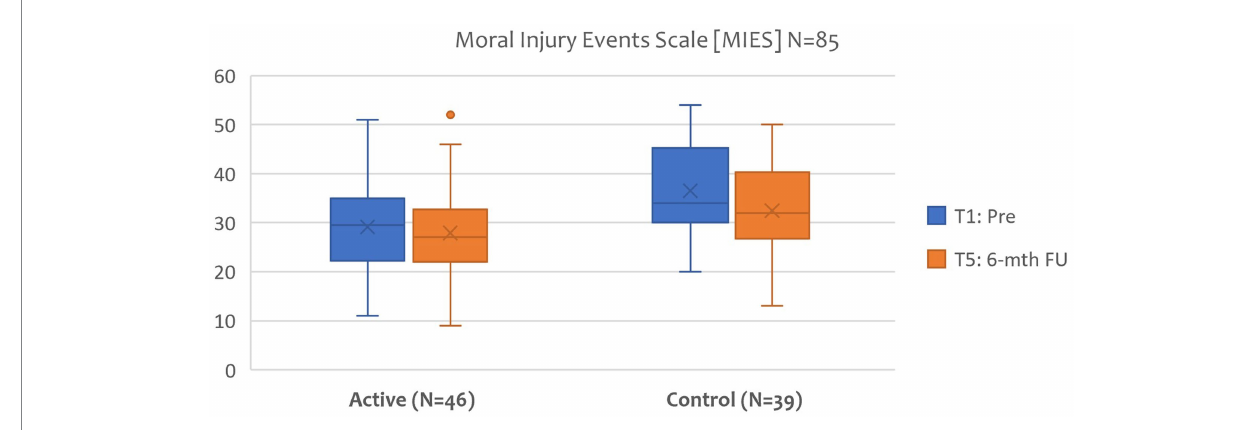
FIGURE 8 Moral injury events scale (MIES): T1 Pre and T5 6-mth FU ( N =85)..